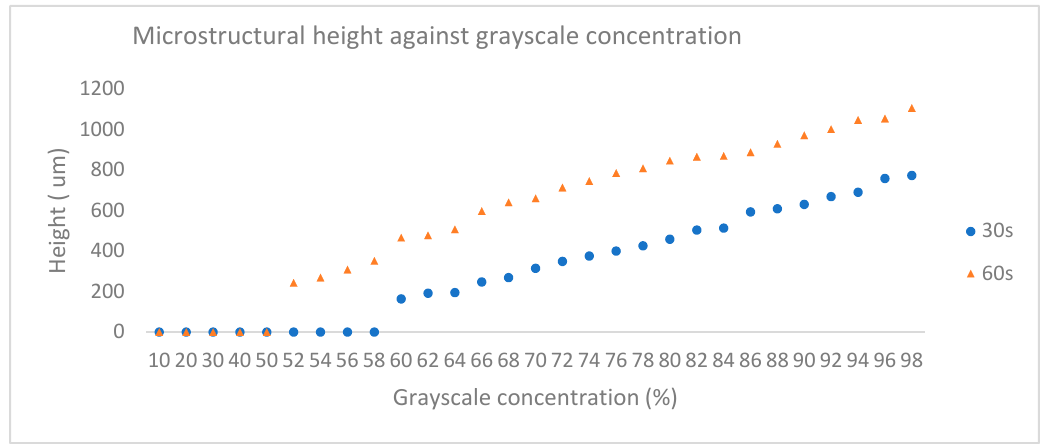
Figure 7. Photoresist thickness versus grayscale concentration (10%–98%) plot for 30 and 60 s UV exposure time.